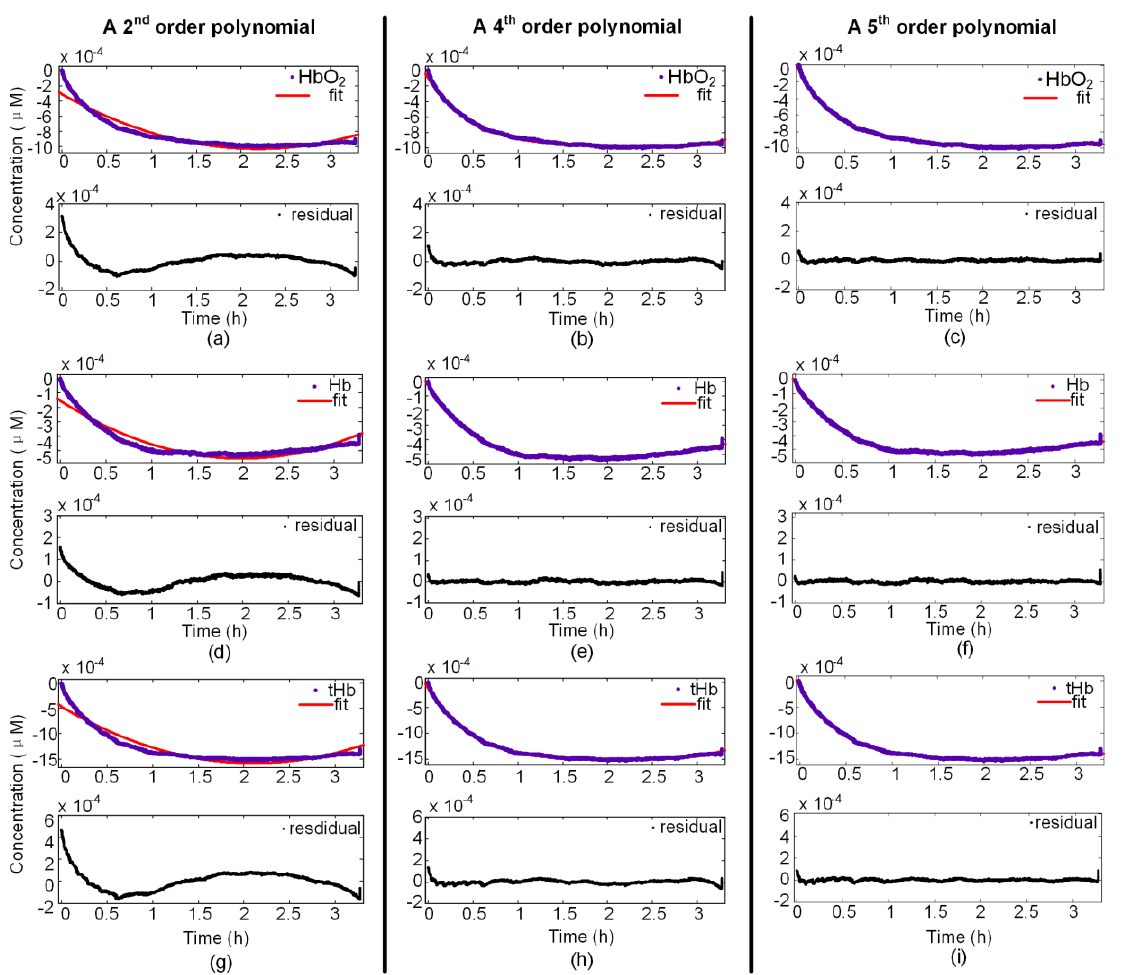
Figure 2. Comparisons of goodness of fit among second-order, fourth-order, and fifth-order polynomials for Probe 3 Channel 1. HbO 2 : oxygenated hemoglobin; Hb: deoxygenated hemoglobin; tHb: total hemoglobin; fit: fit data.